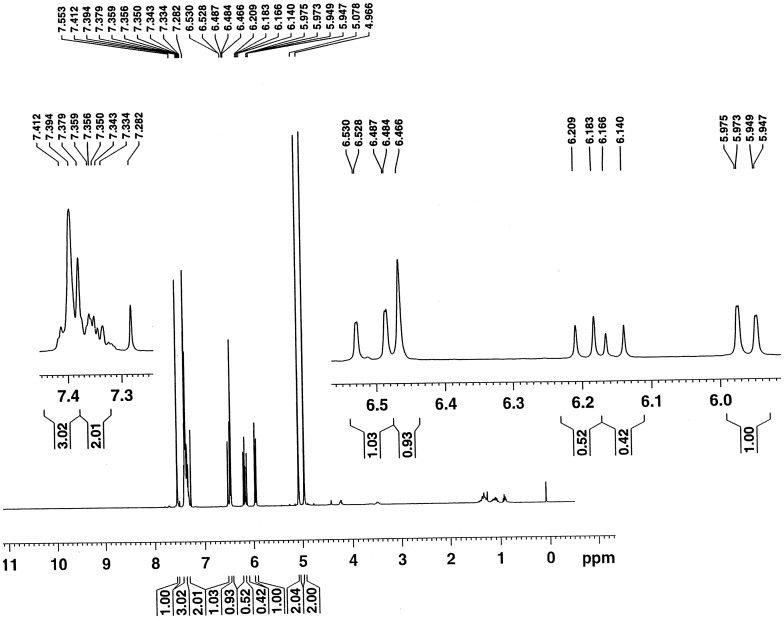

1H NMR spectrum of the monomer 2 in CDCl3
.